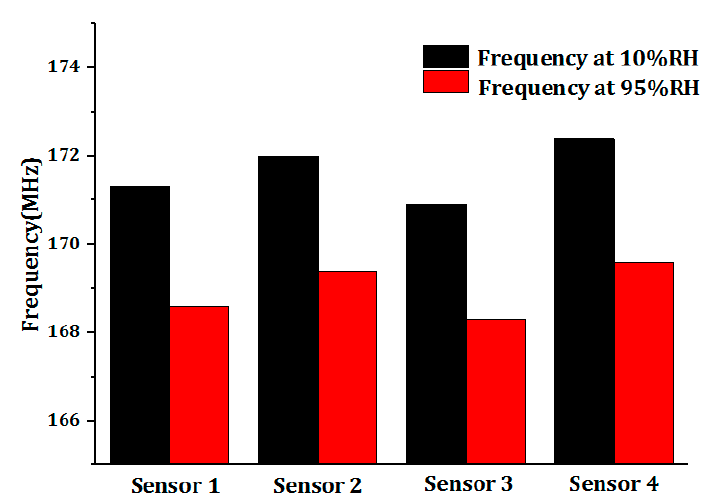
Figure 3. The frequencies of sensors at 10 %RH and 95 %RH.